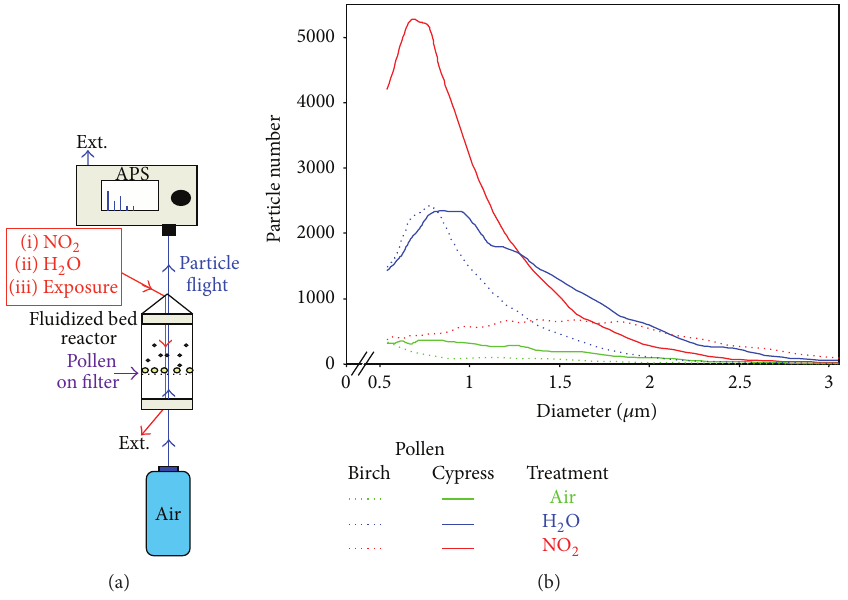
Figure 3: Experimental exposure of cypress and birch pollen with nitrogen dioxide (NO 2 ). (a) Cypress (25–30 𝜇 m) or birch (20 𝜇 m) pollen grains, filed on filter (0.22 𝜇 m), were aerosolized into a synthetic industrial air flow of 100 mL/min (allowing the flight of smaller particles than pollen) and sent into an impactor equipped solely with a PM 10 stage. Particle size distributions were measured, during 10min, at the outlet of the impactor with an aerosol particle sizer (APS) (0.5–20 𝜇 m). (b) Pollen samples were moistened and then dried with air during 10min (blue curves) and control samples were realized with industrial air (green curves). Impaction tests were also done with pollen grains artificially polluted with NO 2 (0.5% for 10min) (red curves). Particle size distributions were normalized to show an equal number of pollen grains at 17 𝜇